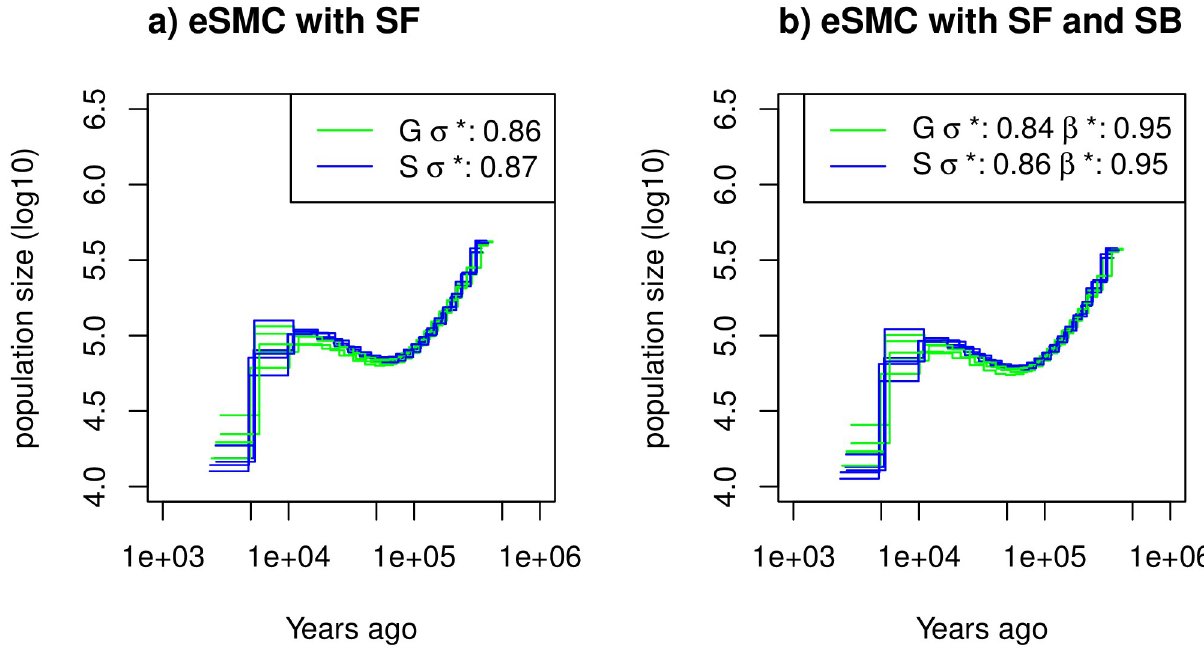
Fig 5. Estimated demographic history of Arabidopsis thalinana . Demographic history of two European (Sweden (S, blue) and German (G, green)) populations of A . thaliana estimated using eSMC: a) accounting only for selfing ( σ is a variable and β = 1) and b) accounting simultaneously for selfing and seed-banking ( σ bounded between 0.5 and 0.99 and β bounded between 0.5 and 1). Mutation rate is set to 7 × 10 − 9 per generation per bp and recombination respectively set for chromosome 1 to 5 to 3.4 × 10 − 8 , 3.6 × 10 − 8 , 3.5 × 10 − 8 , 3.8 × 10 − 8 , 3.6 × 10 − 8 ) per generation per bp. σ � and β � respectively represent the estimated self-fertilization and germination rates.